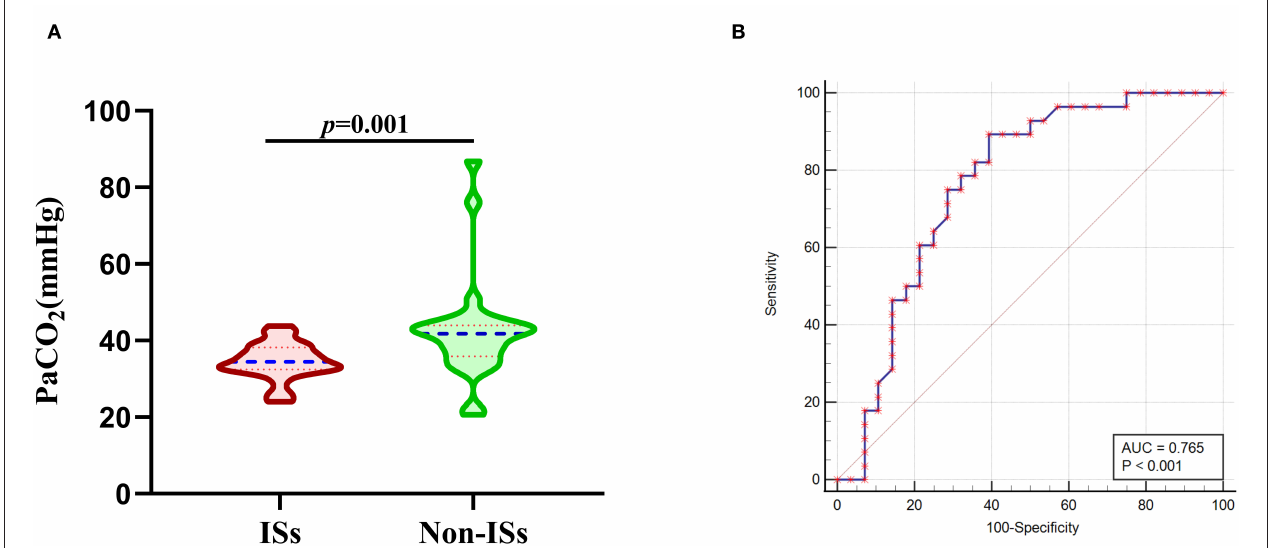
FIGURE 3 | Association of initial PaCO 2 levels with ISs after PSM. (A) PaCO 2 levels in patients with ISs ( n = 28) and non-ISs ( n = 28) after propensity-score matching. (B) ROC curve analysis for predicting ISs after PSM. The optimal cutoff value for PaCO 2 levels as a predictor for ISs following primary ICH was determined as 39.4mmHg (the AUC was 0.765 with a corresponding sensitivity of 89.29% and specificity of 60.71%, 95%CI = 0.632–0.868). Median with IQR was shown for all violin plots in (A) . Mann-Whitney tests were performed to compare differences between groups. AUC, area under the curve; ICH, intracerebral hemorrhage; ISs,